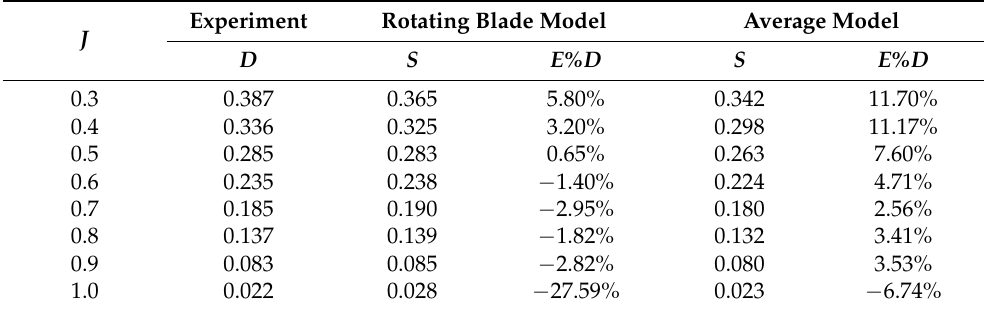
Figure 8. Open water curve for KP505 propeller. EFD(NMRI) = experiment, CFD(AVE) = average body force propeller model, CFD(ROT.B) = rotating blade body force. Table 4. Error analysis for thrust coefficient KT .